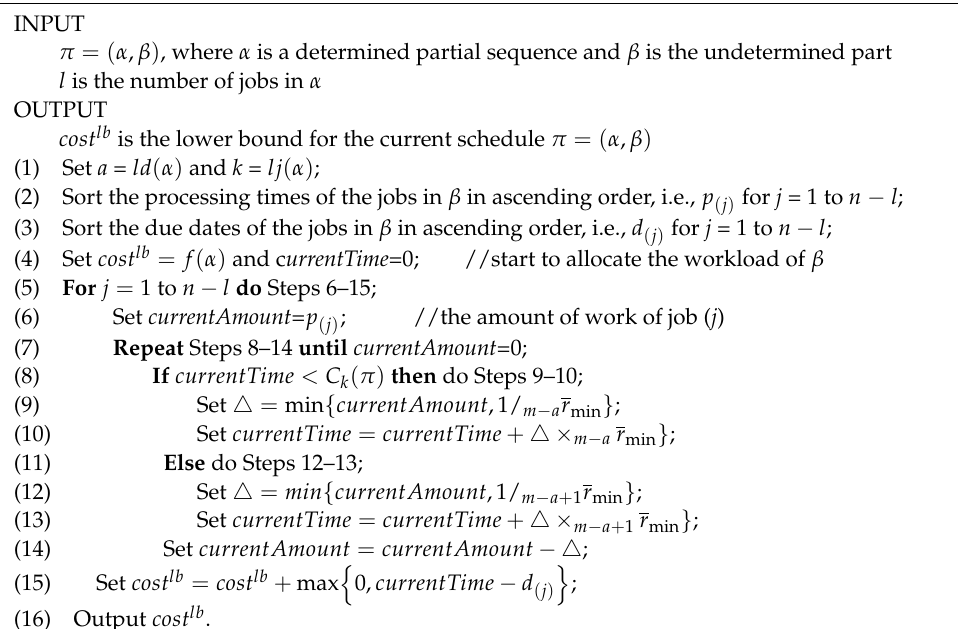
Algorithm 1. The proposed lower bound ( LB ( π , l